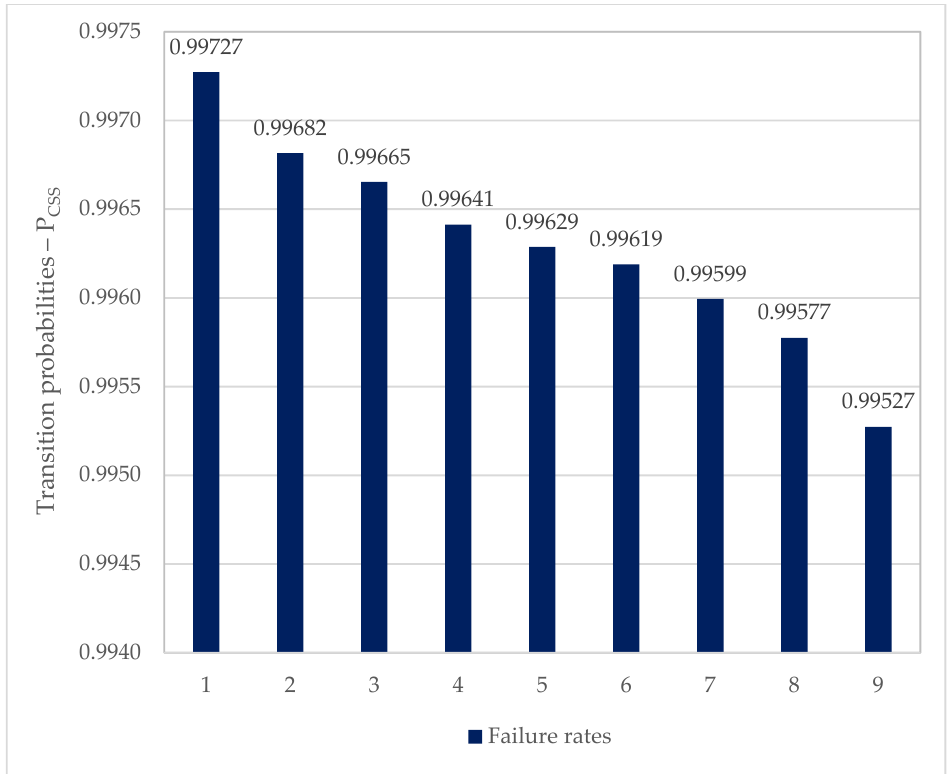
Figure 3. Dependence of the P CSS values on the failure rates λ CSS, λ TSS, and λ LSS acc. to Figure 2, for the constant µ TSS = 1.0399 d − 1 and µ LSS = 0.0276 d − 1